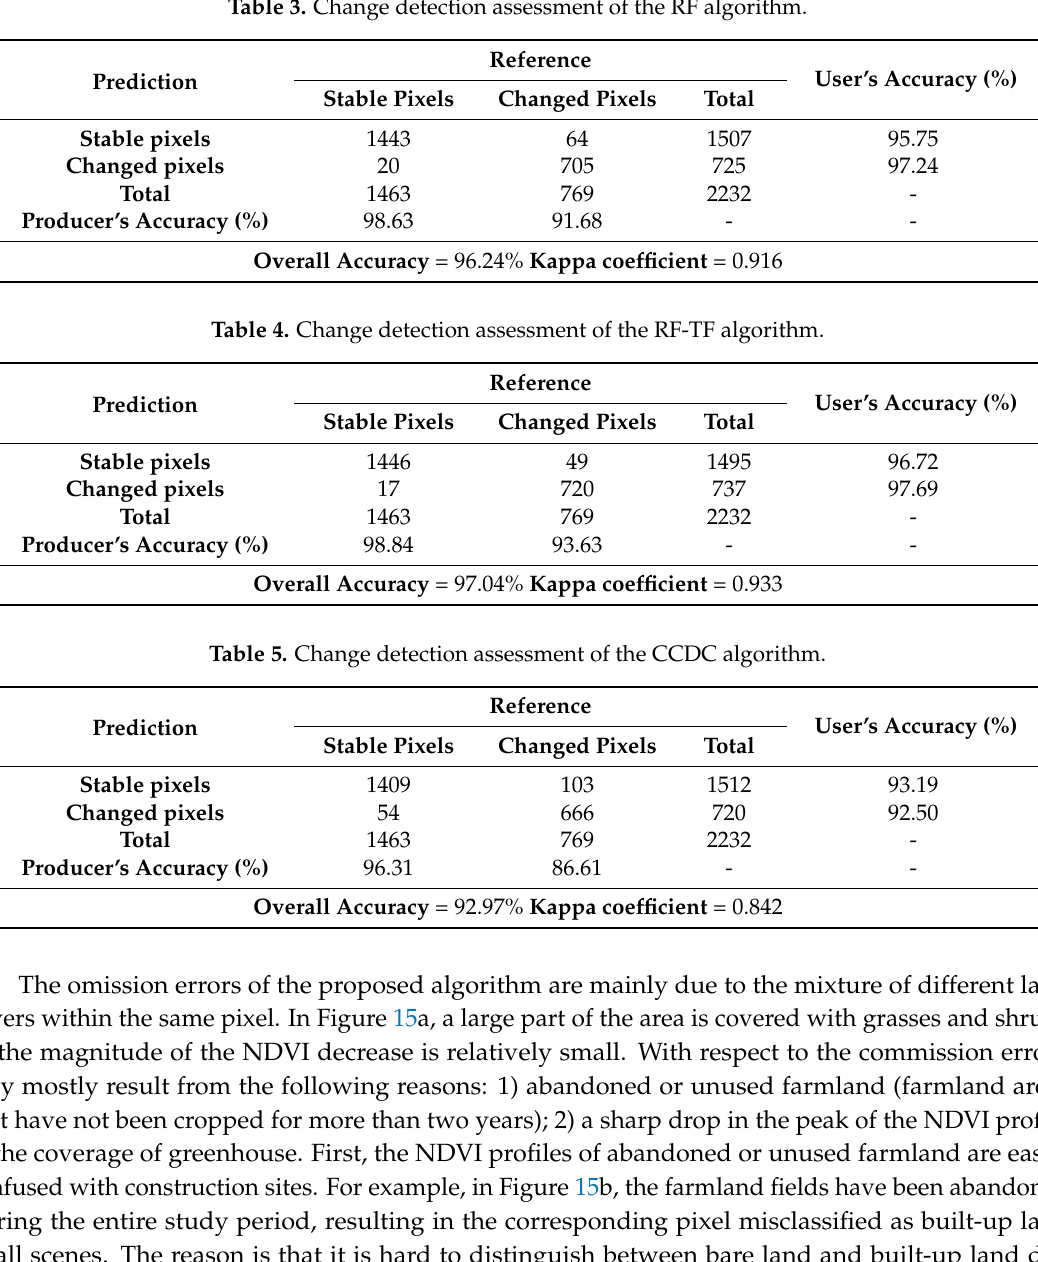
Table 3. Change detection assessment of the RF algorithm.